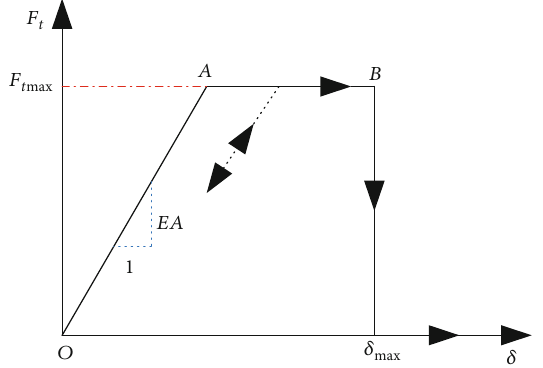
Figure 5: The modi fi ed tensile-rupture mechanical model of the FLAC3D-